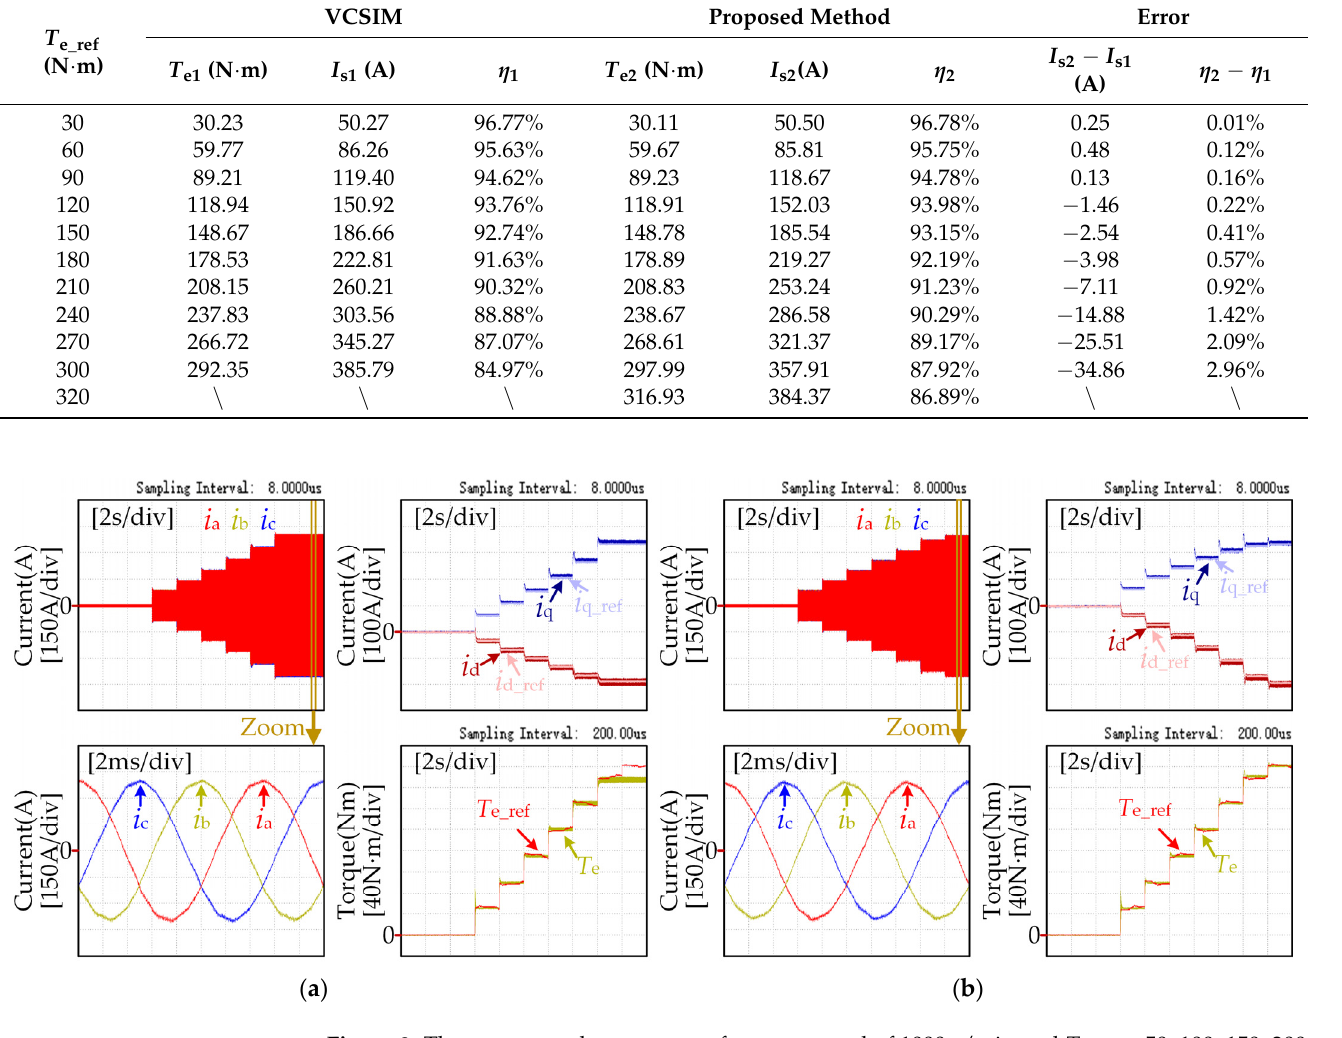
Figure 8. The current and torque waveforms at speed of 1000 r/min and T e_ref = 50, 100, 150, 200, 250, 300, 320 N · m: (a) VCSIM; ( b ) the proposed